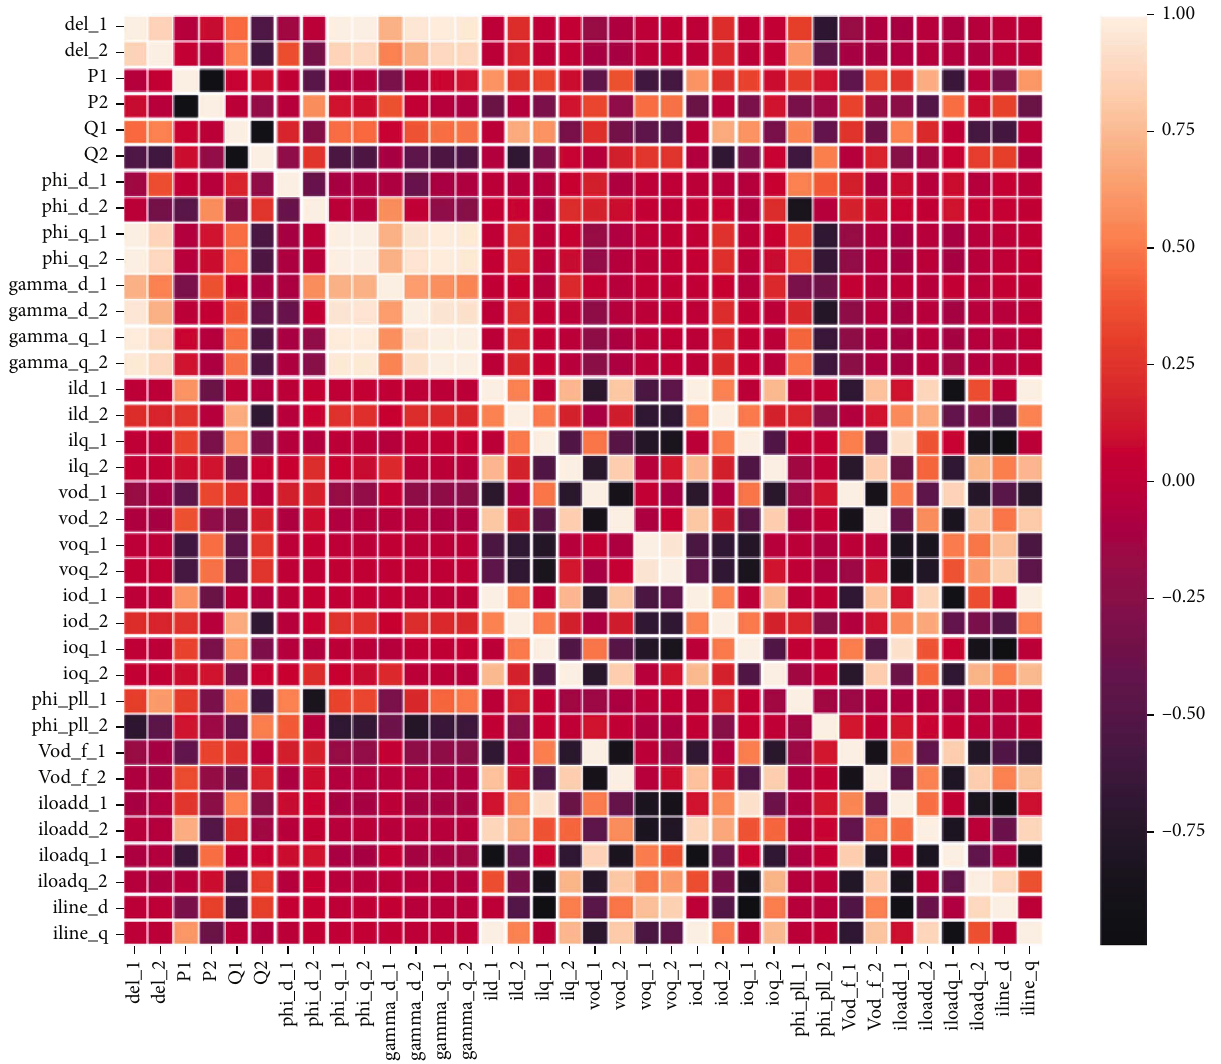
Figure 19: Heatmap of variables in (30) eigenvalues for state